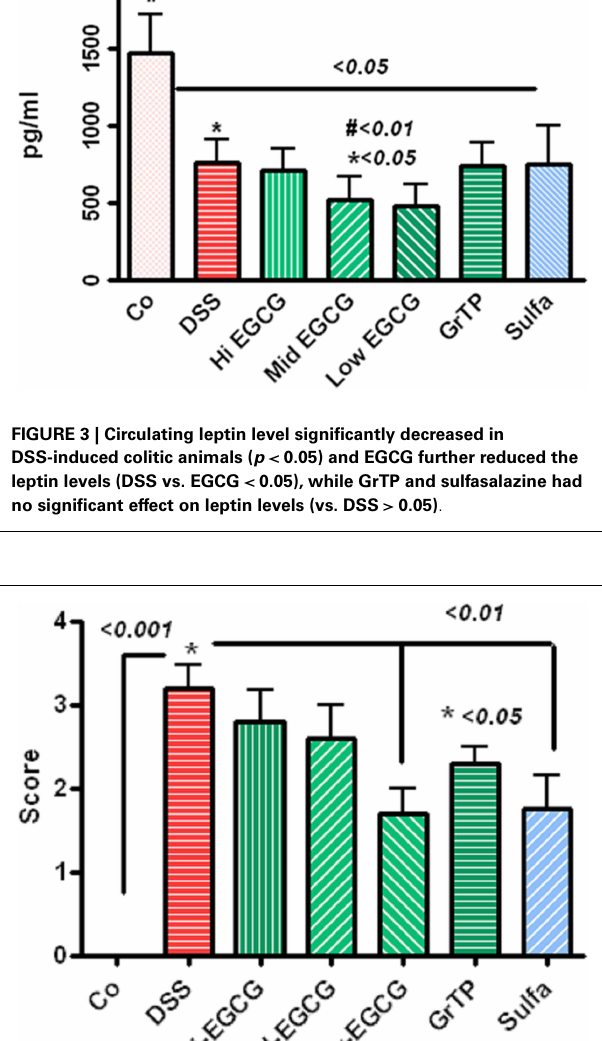
the gut integrity. Hepatic GSH ( p < 0 . 01) which is the